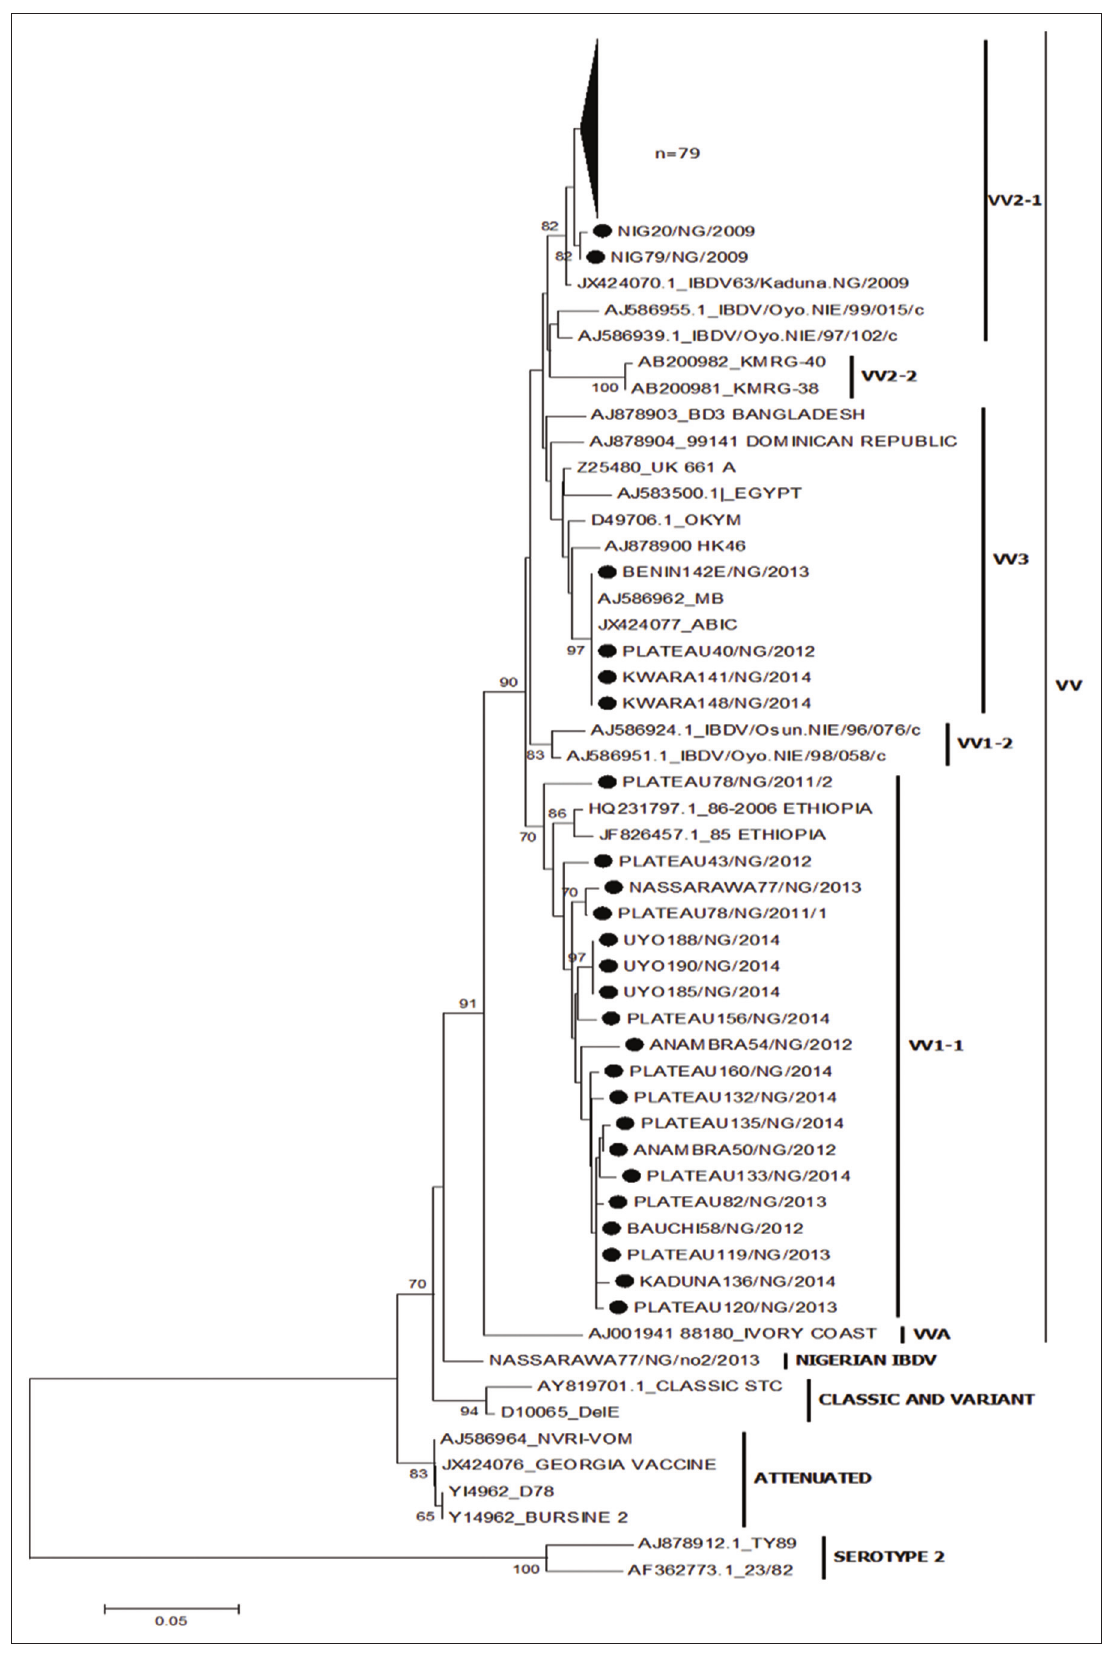
Figure-2: Phylogenetic analysis of the VP2 hypervariable region nucleotide sequences of Nigerian infectious bursal disease virus (IBDVs) and other IBDV strains from Genbank using the neighbor joining method with 1000 bootstrap replication. mutations affected phylogenetic clustering of Nigerian IBDV strains with identical VP2 amino acid sequences and other IBDV strains and that different clusters of were formed based on a specific pattern of